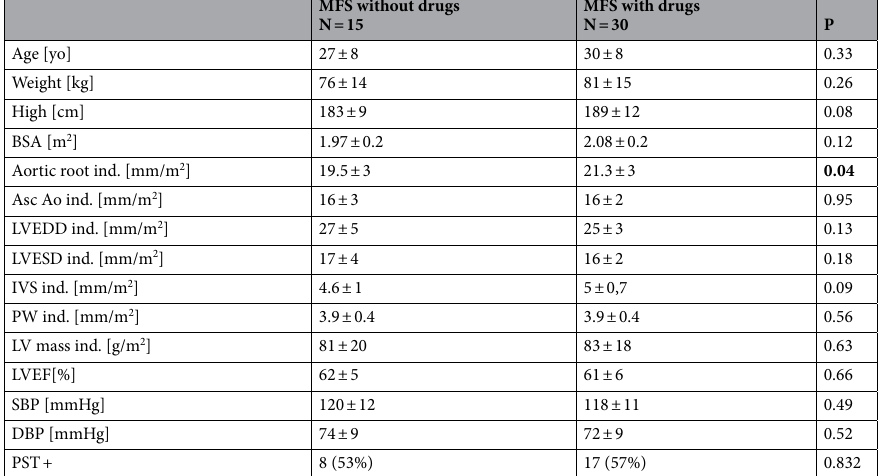
Table 5. Left ventricular and aortic remodeling in humans according to medical treatment. BSA body surface area, AoR aortic root diameter, Asc Ao ascending aorta diameter, LVEDD left ventricular end- diastolic diameter, LVESD left ventricular end-systolic diameter, LVEF left ventricular ejection fraction, IVS interventricular septum thickness, PW posterior wall thickness, SBP systolic blood pressure, DBP diastolic blood pressure, PST: postsystolic thickening, ind.: indexed by BSA. Data is presented as mean ± SD for continuous variables. Independent two-sample t-test for normally distributed continuous variables and the Mann–Whitney U test for non-parametric distribution were used. Categorical variable (PST) is presented as percentage (%) and compared using χ 2 test. P<0.05, in bold, denote statistical